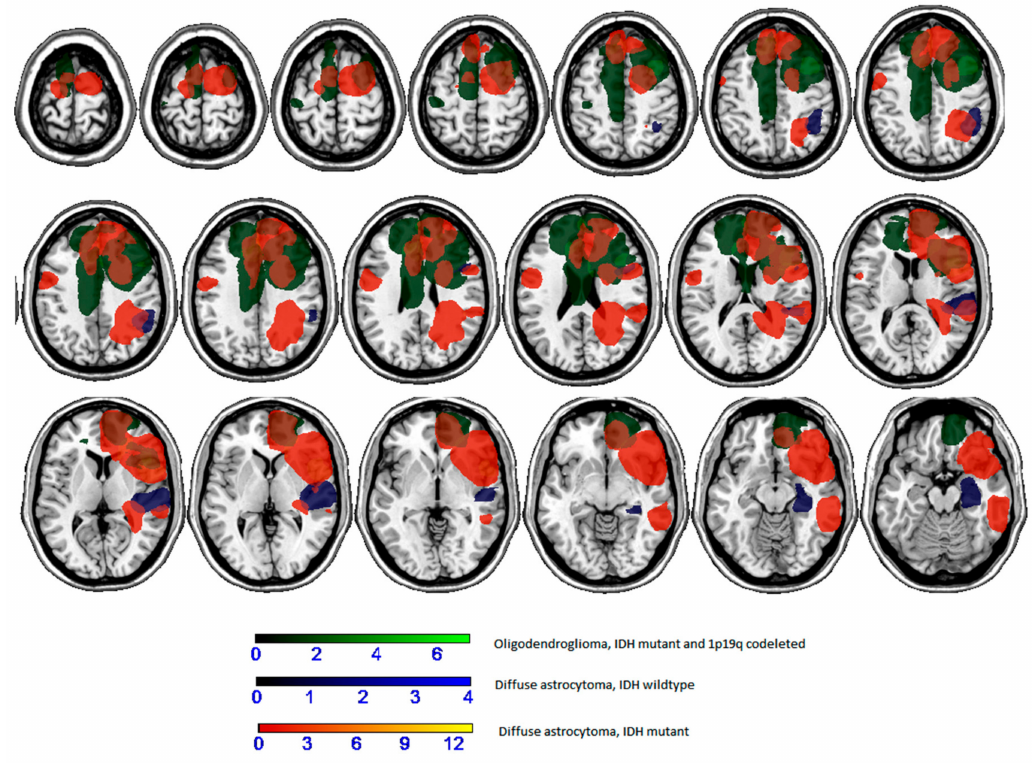
Figure 3. Overlaps of lesion masks according to molecular